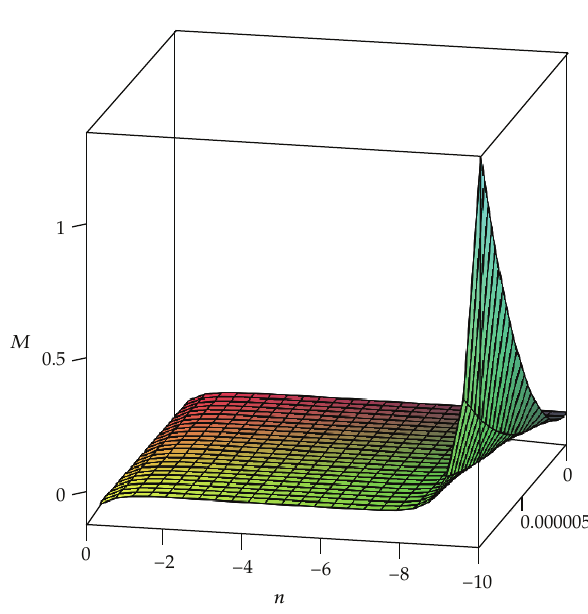
− m 2 (cid:2) 4 (cid:3) versus n and γ e ff